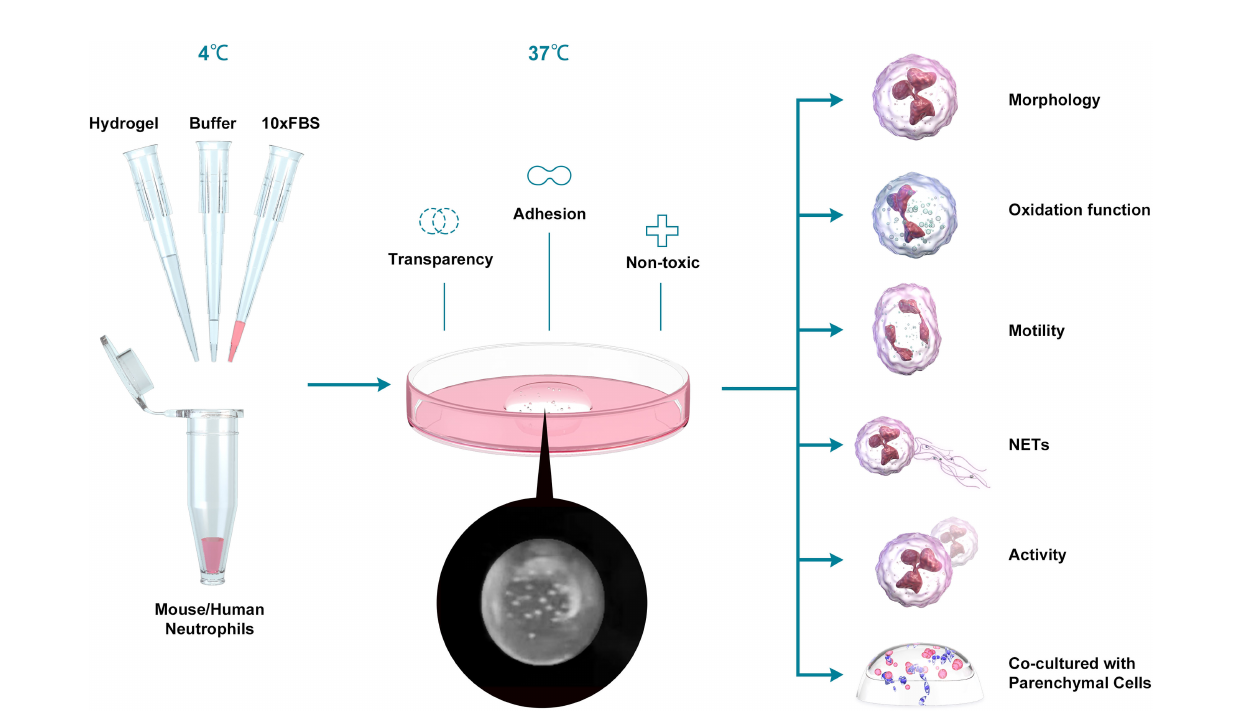
FIGURE 1 | Schematic depiction of the experiment. We mixed hydrogel, buffer, FBS and Neu, incubated at 37 °C for 30 min and added the medium to culture the cells. Then we tested the oxidation function, the motility, the NETs production, activity and the ability to co-culture with Parenchymal cells between Neu in 2D and 3D culture